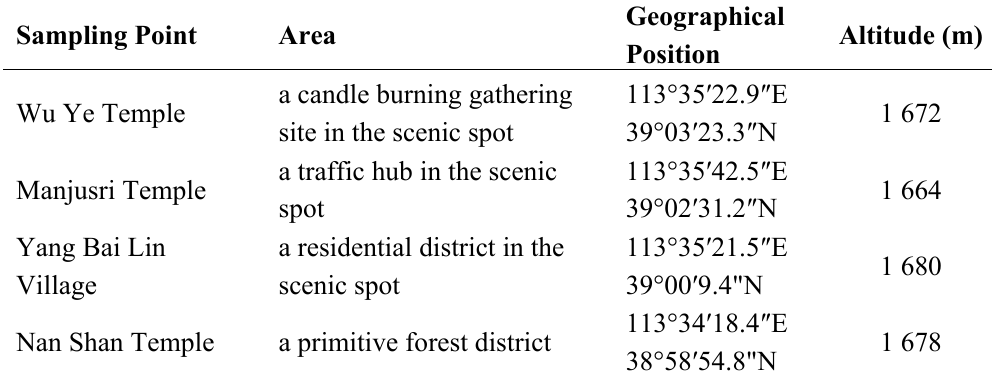
Table 1. Information on the sampling areas in Mount Wutai, Shanxi,